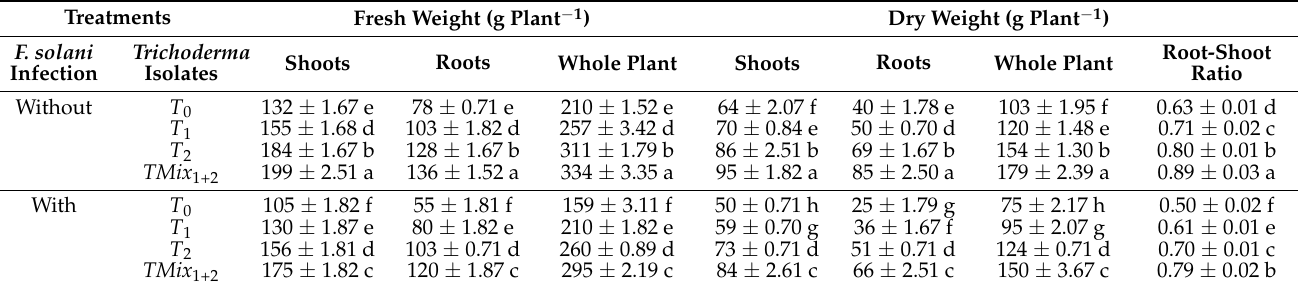
Table 2. Plant growth promoting effects of different Trichoderma treatments on cherry tomato plants cultivated in greenhouse conditions either with and/or without F. solani infested soil.